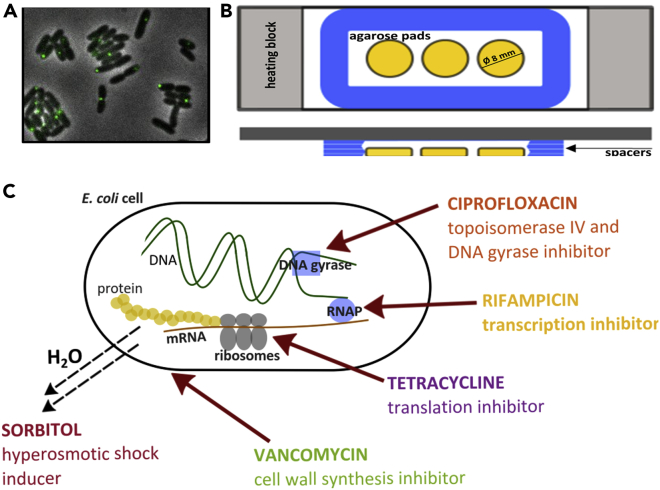
Experimental ApproachChromosomal and cytosolic markers are tracked in each cell, under treatments with antibiotic and crowding agents.The trajectories are quantified through the mean square displacement (MSD) of the fluorescent tracer, either chromosomal or cytosolic, following the methods of Wlodarski et al. (2017). All MSD are well described by power laws of the time interval τ, τα. One expects the MSD amplitude to be inversely proportional to the viscoelastic resistance of the surrounding medium. Chromosomal Ori2 and Ter3 loci explore space slower than the cytosolic μNS aggregates.(A) Example of phase contrast image of live E. coli cells, overlayed to the fluorescence channel showing chromosomal loci (green).(B) The schematic top and side views show how the samples are contained for live imaging: agarose pads (yellow) are sealed between a coverslip and a glass slide with spacers (blue) and sit on a heating block (gray) for temperature control.(C) We explore sub-lethal doses of four antibiotics, chosen from four major antibiotic classes, and a hyperosmotic shock-inducing agent, sorbitol. The antibiotics are chosen to have very different targets: DNA replication (ciprofloxacin), transcription (ciprofloxacin and rifampicin), translation (tetracycline and chloramphenicol), and cell wall synthesis inhibitors (vancomycin).